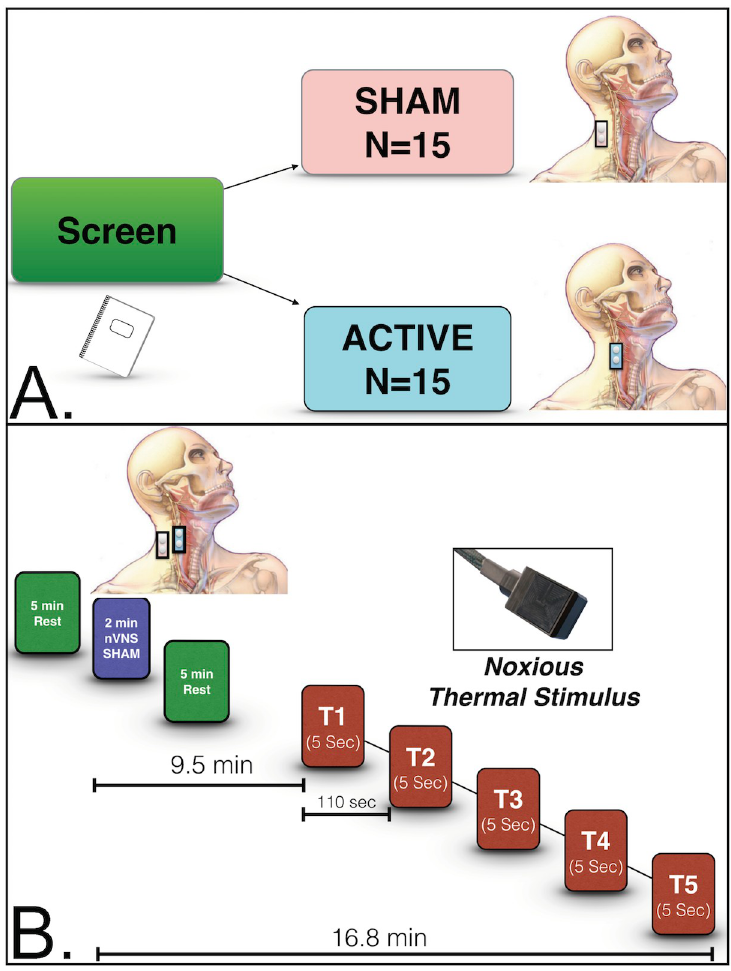
Fig 1. Noninvasive vagus nerve stimulation study design. (a) Subjects were screened and randomized to either the sham treatment or nVNS group. Sham stimulation was carried out posteriolateral to the sternocleidomastoid. In the nVNS group, stimulation occurred anteromedial to the sternocleidomastoid and lateral to the trachea. In both the nVNS and sham treatments, a computational fixed, initial 30-second ramp-up period was followed by 90 seconds of peak stimulation. (b ) Subjects were allowed to rest for 5 minutes before undergoing 2 minutes of nVNS (electrodes placed over carotid) or sham stimulation (electrodes placed far lateral to the sternocleidomastoid). Subjects then rested for an additional 5 minutes. Nine and a half minutes after either nVNS or sham stimulation, 5 successive noxious thermal stimuli were applied in bouts of 5 seconds each, up to 49.8˚C. Each heat stimulus began 110 seconds after the start of the previous one. fMRI, and GSR acquisition were taken 9.5 to 16.8 minutes after nVNS or sham